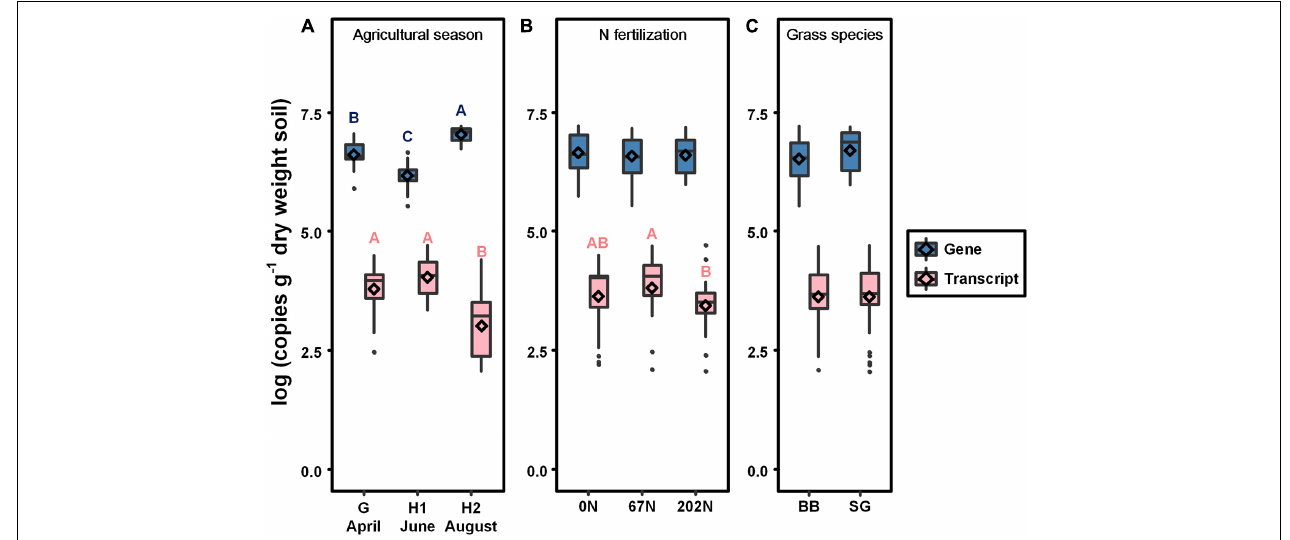
FIGURE 2 | Absolute abundance of nifH gene (blue) and transcript (pink) in relation to agricultural seasons (A) , nitrogen fertilization rates (B) , and grass species (C) . Boxes represent the interquartile range (IQR). Lines within boxes represent median values. Whiskers represent the range between minimum and maximum values. Dots represent outliers outside of this range. Diamonds represent mean values. Different letters above boxes indicate significant differences between treatment levels within groups by comparing means using least significant difference (LSD) tests ( α = 0.05). G, grass green up; H1, initial grass harvest; H2, second grass harvest; 0N, no N fertilization; 67N, 67 kg N ha − 1 fertilization; 202N, 202 kg N ha − 1 fertilization; BB, big bluestem; SG, switchgrass.